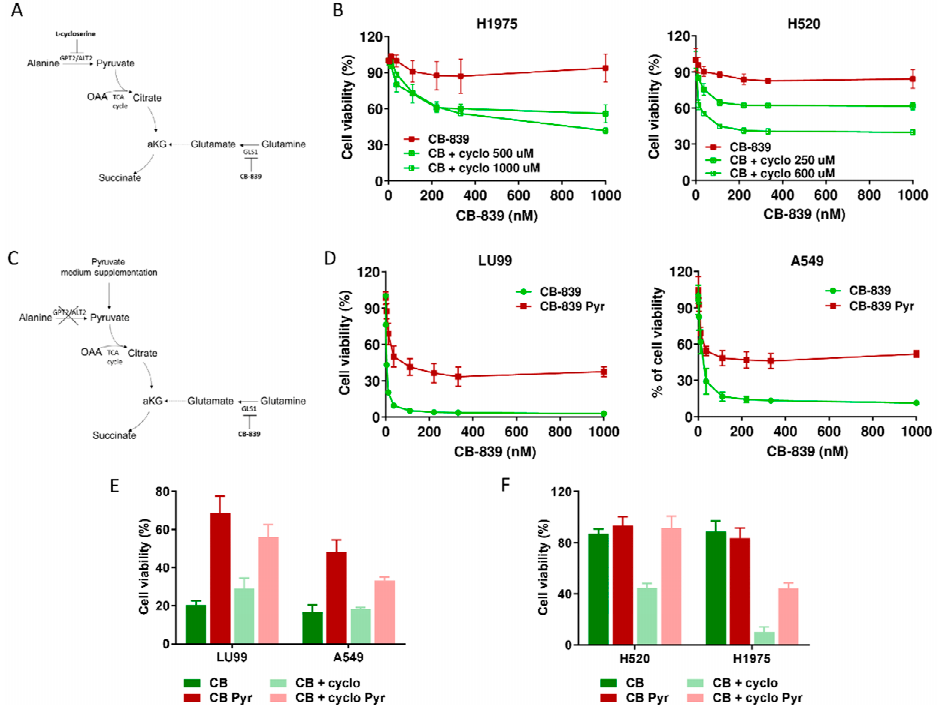
Figure 4. ( A ) Schematic representation of metabolic strategy to overcome CB-839 resistance, targeting GPT2 by l -cycloserine (cyclo). ( B ) Dose–response curves of H1975 (left panel) and H520 (right panel) cells treated with increasing concentrations of CB-839, alone (CB-839) or with l -cycloserine (CB + cyclo) at the reported concentrations. The response to the drugs was assessed with the MTS assay 72 h from the treatment start. ( C ) Schematic representation of metabolic strategy to induce CB-839 resistance in the sensitive cell lines by pyruvate supplementation, with inhibition of GLS1, alone or together with GPT2. ( D ) Dose–response curves of LU99 (left panel) and A549 (right panel) cells treated with increasing concentrations of CB-839, grown and treated in standard (CB-839) or pyruvate-enriched medium (CB-839 Pyr). The response to the drug was assessed with the MTS assay 72 h from treatment start. ( E ) Histograms of LU99 and A549 cells grown in standard or pyruvate-enriched medium (Pyr) and treated with CB-839 (CB, 12 nM for LU99 and 111 nM for A549) and l -cycloserine (cyclo, 75 µ M for LU99 and 100 µ M for A549), either alone or in combination. The response to the drug was assessed 72 h from the start of treatment with the MTS assay. ( F ) Histograms of H520 and H1975 cells grown in standard or pyruvate-enriched medium (Pyr) and treated with CB-839 (CB, 1000 nM) and l -cycloserine (cyclo), 250 µ M for H520 and 500 µ M for H1975), either alone or in combination. The response to the drug was assessed with the MTS assay 72 h from treatment start. The average of three independent experiments is reported. For the sake of clarity, the statistical significance one-way ANOVA and Bonferroni post-test for multiple comparisons (panel B , D , E , F ) are reported as Supplemental Table S1, Table S2, Table S3 and Table S4, respectively) .